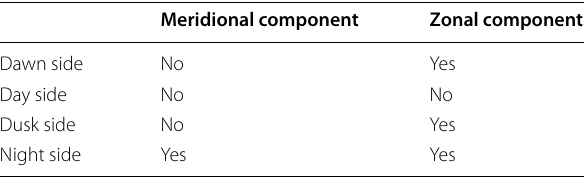
Table 2 Results of the t tests for significance of amplitude differences Meridional component Zonal